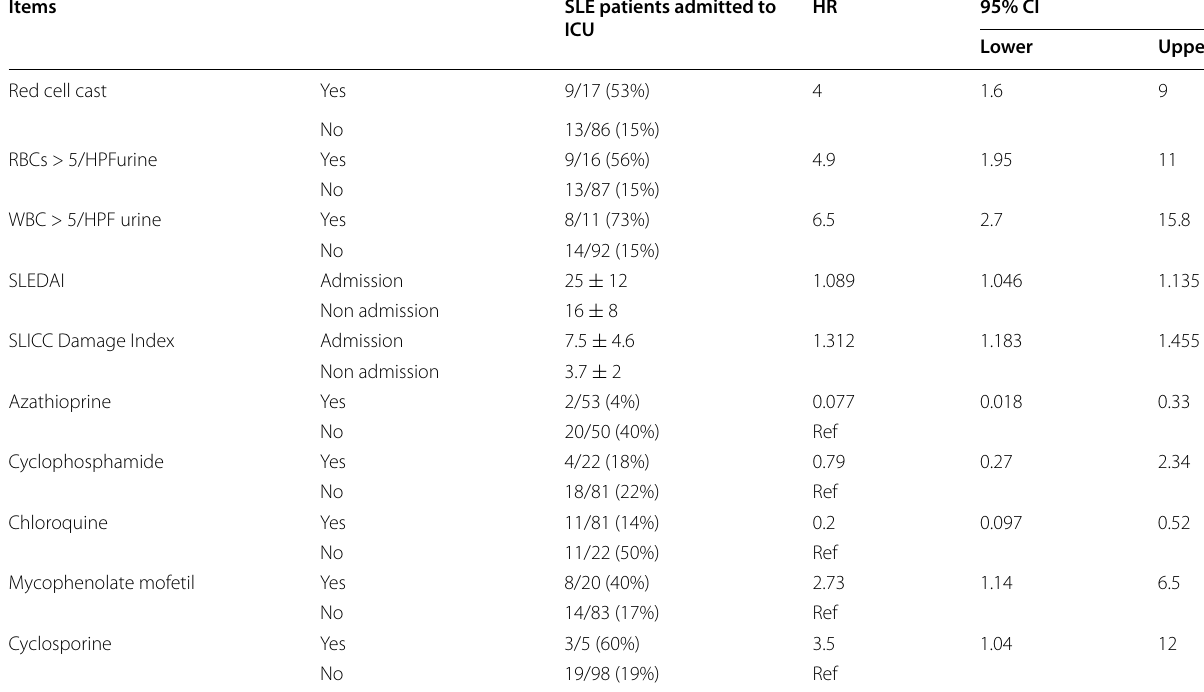
Table 4 Multivariable Cox regression models assessing factors predicting progression to ICU admission during 12‑month follow‑up of 103 SLE patients